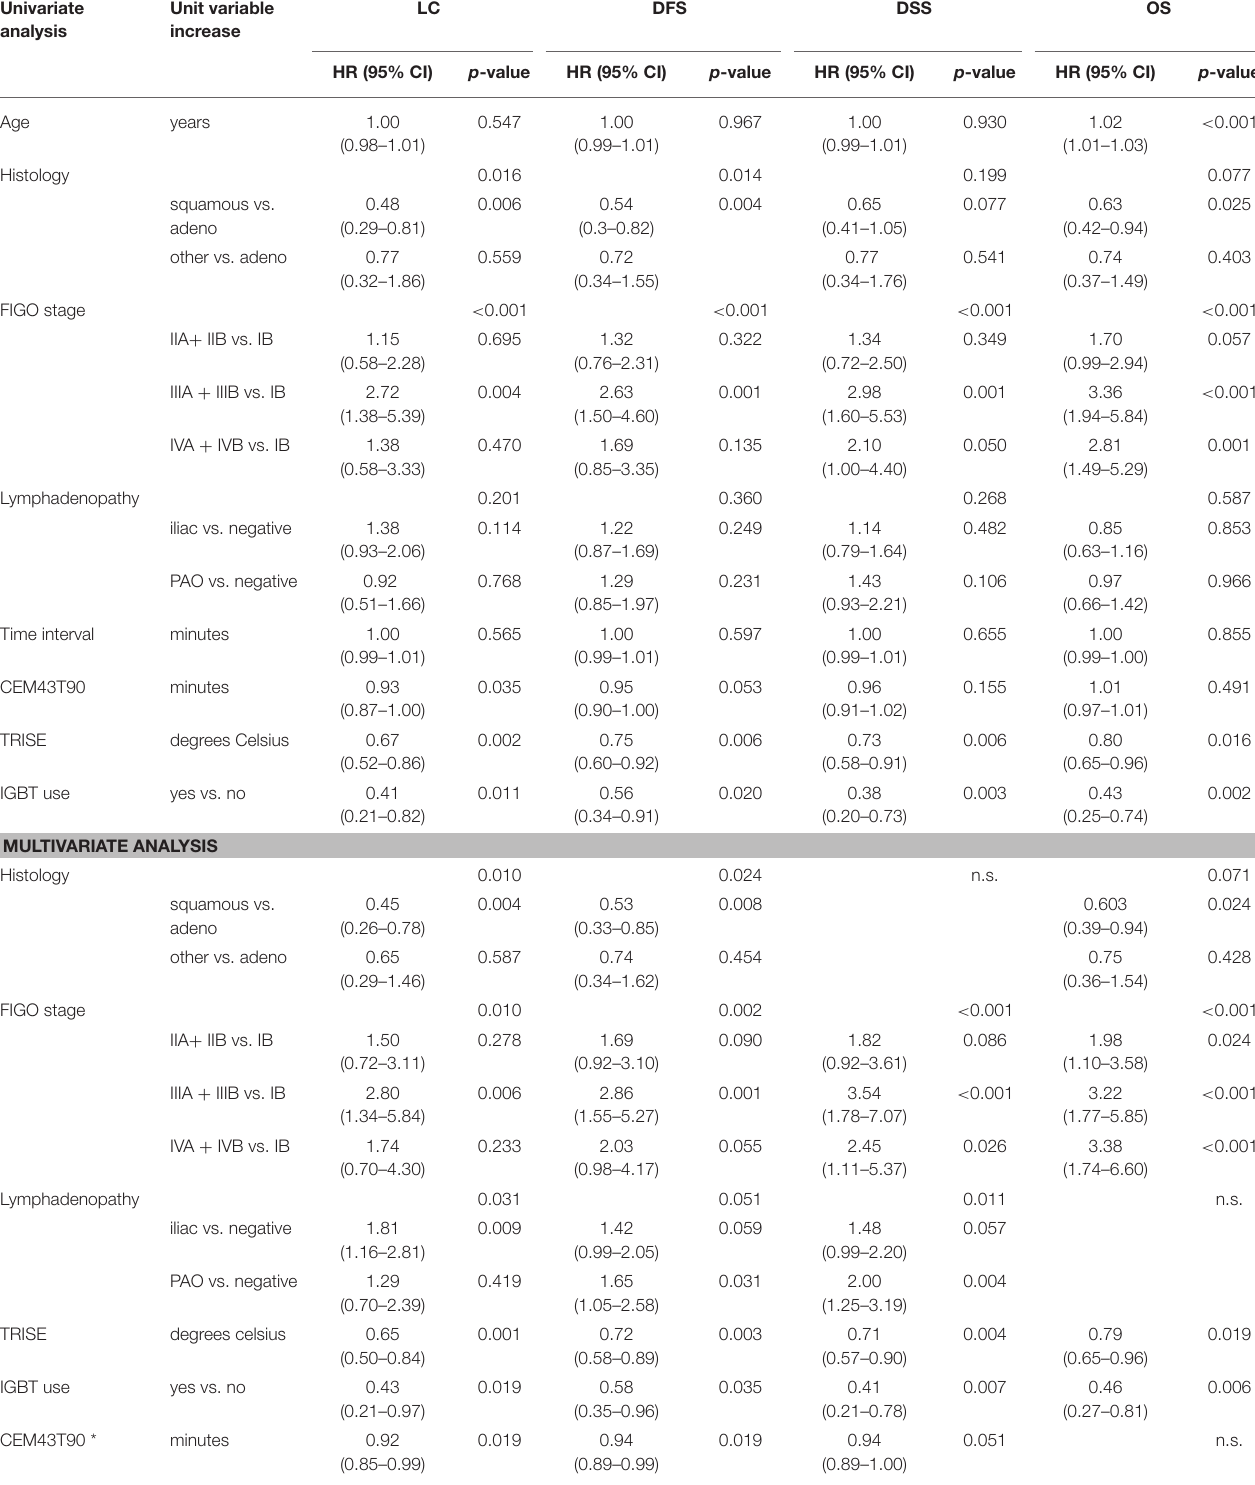
TABLE 3 | Univariate and multivariate Cox regression analysis.